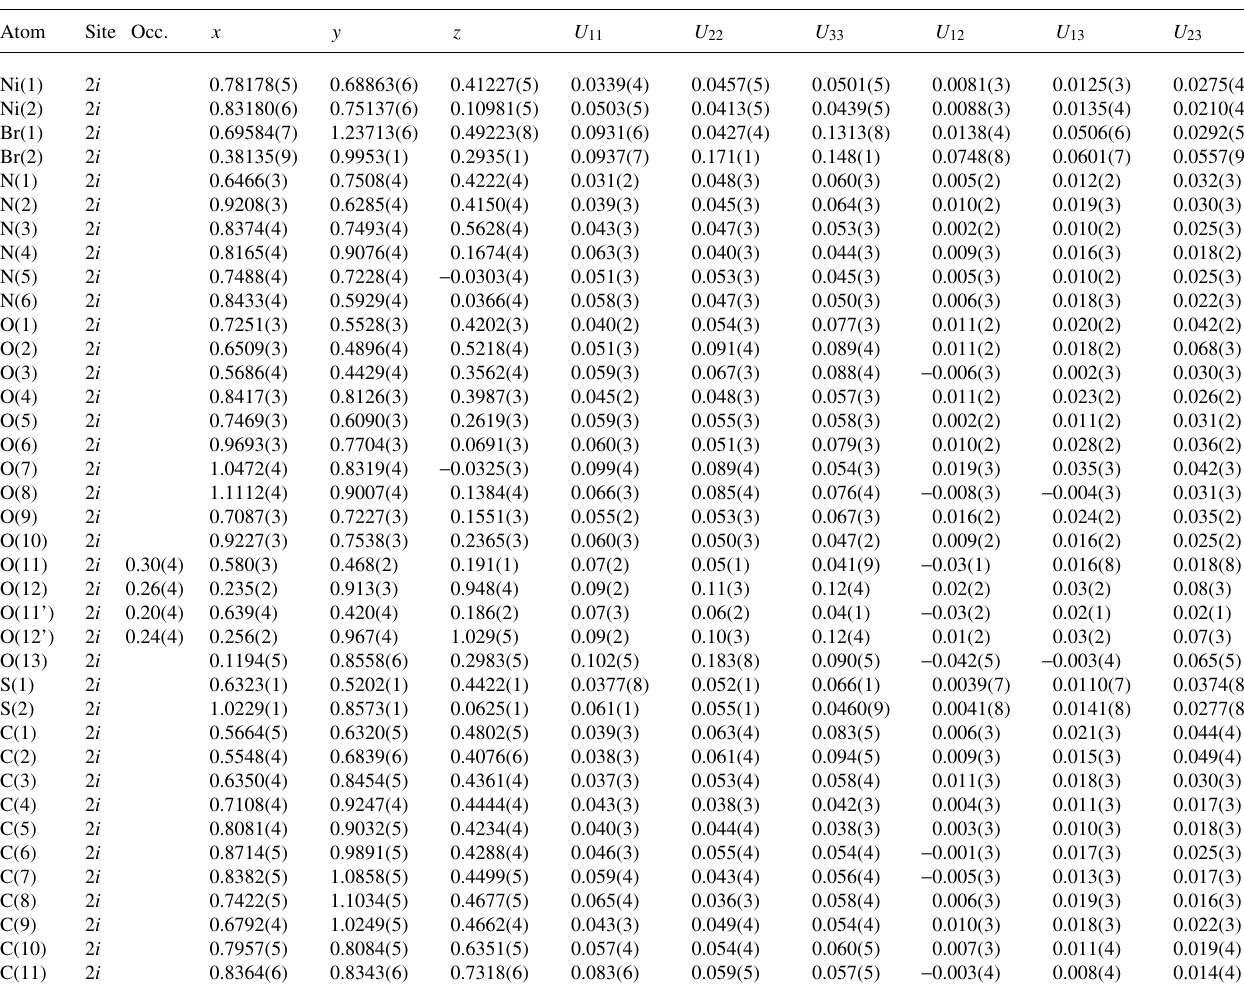
Table 3. Atomic coordinates and displacement parameters (in Å 2 ) .